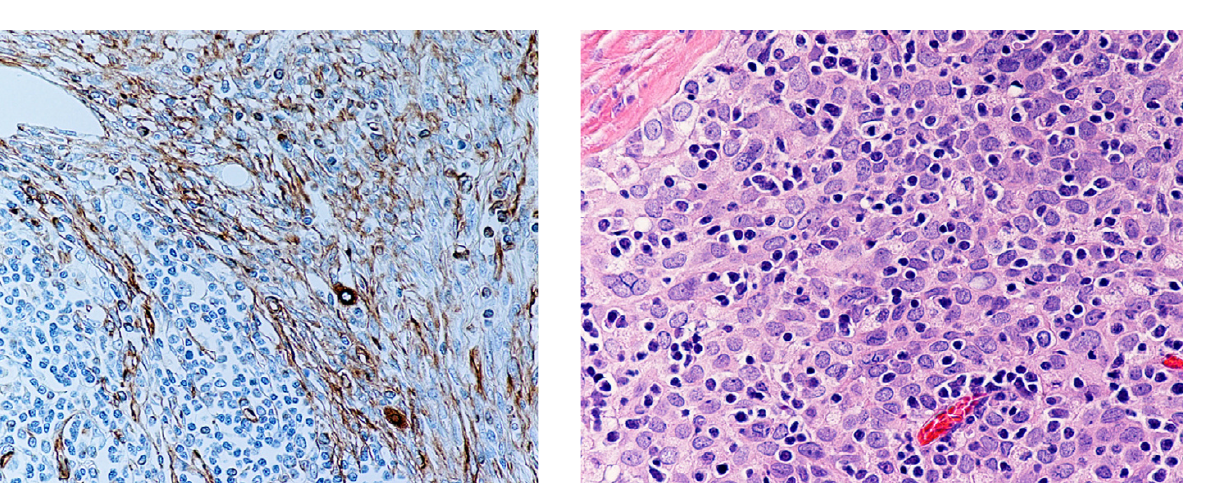
Figure 5 (B-SA, anti-vimentin, × 200): Type AB thymoma. Neoplastic epithelial cells in type A component express vimentin.